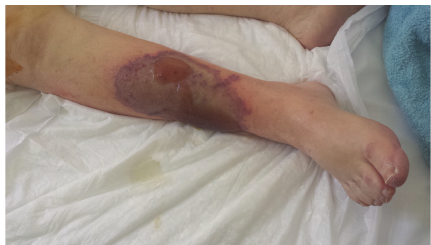
Figure 1: Patient’s right leg at presentation to the vascular department.